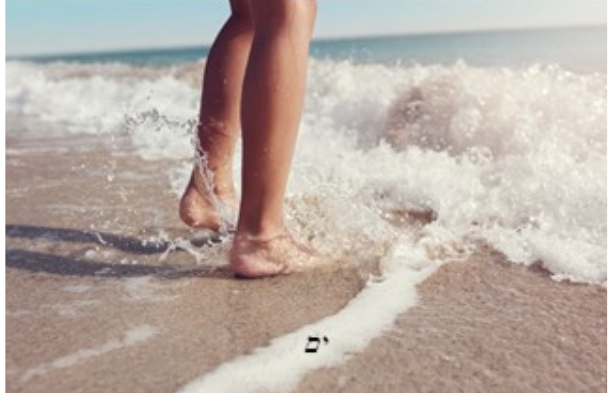
Figure 6. Moshe’s choice of photograph and title “Beach”. Reproduced with permission from www.istockphoto.com (accessed on 29 September 2021).